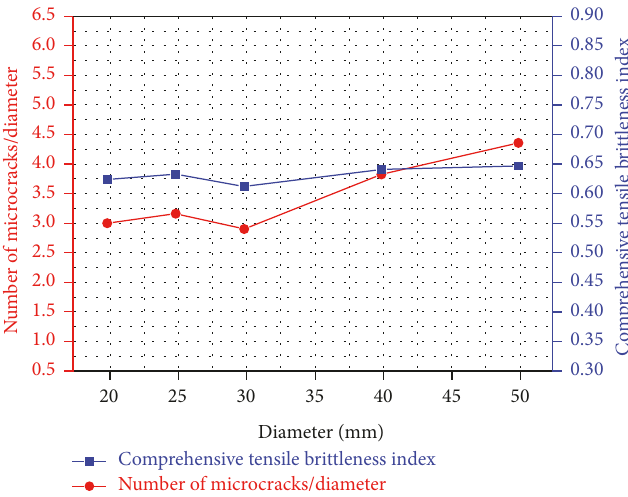
Figure 14: Influence of scale effect on shale